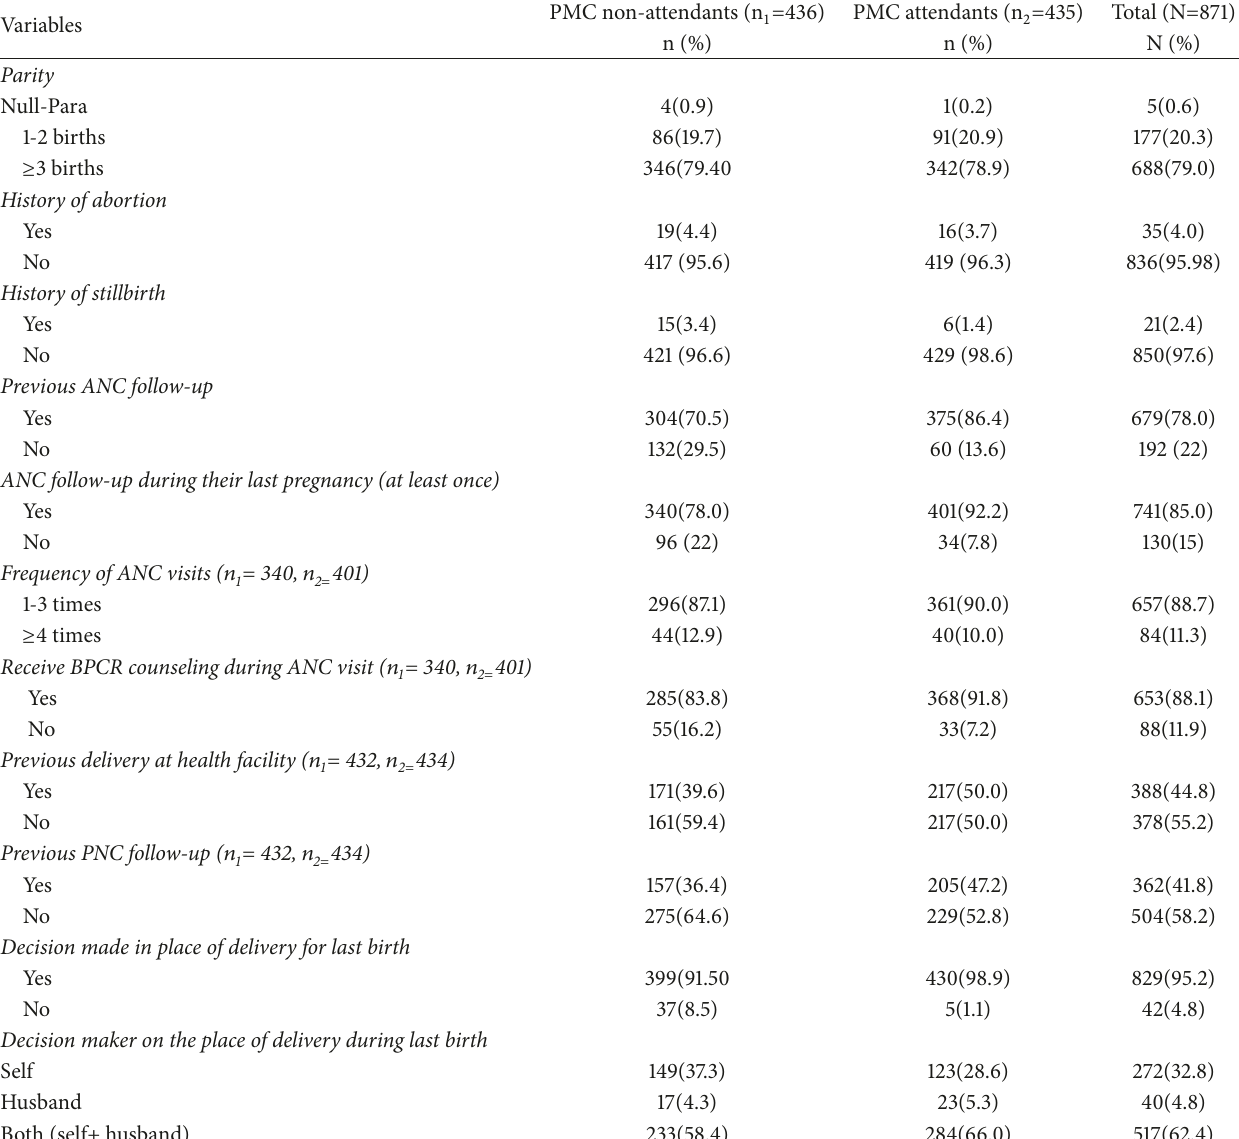
Table 2: Obstetric characteristics of the mothers in Libo Kemkem District, Amhara Region North West Ethiopia, 2017. (N=871).